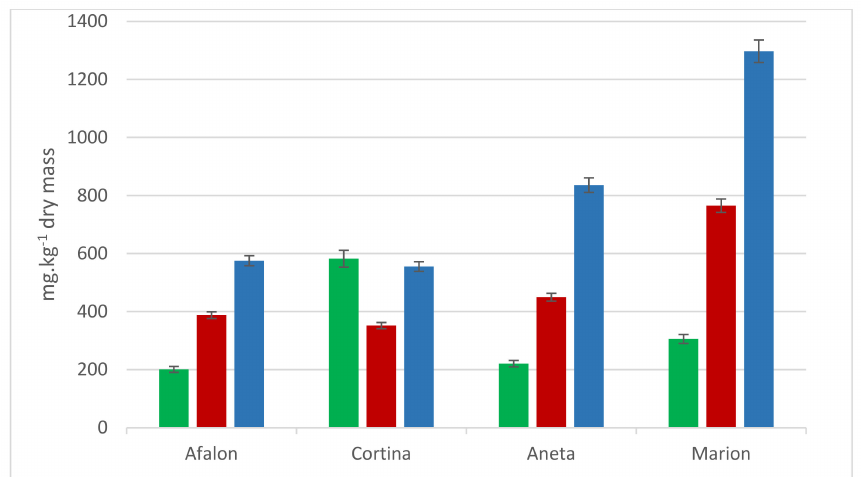
Figure 3. Comparison of AA, β -carotene and α -carotene content in Marion, Aneta, Cortina and Afalon cv. grown in conventional system in crop year 2013, seeding density 9 × 10 5 seeds per ha in mg per kg dry weight; AA, green; β -carotene, red; α -carotene,